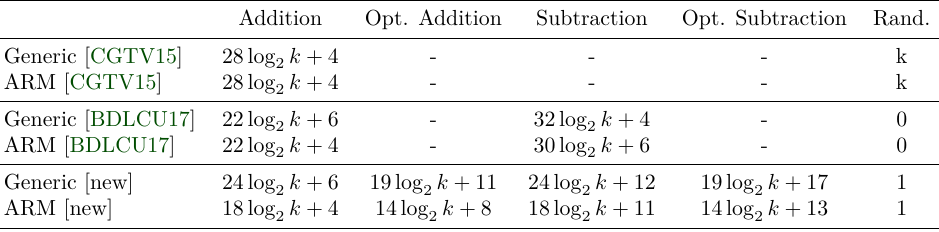
Table 2: Comparison of masked addition and